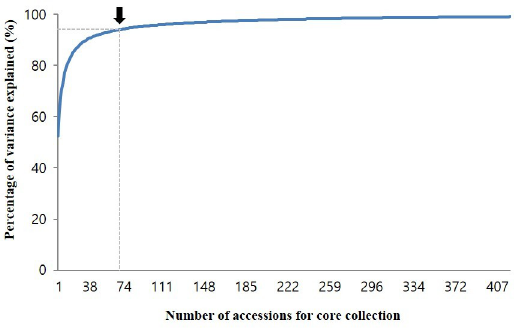
Fig 2. Principal component analysis model statistics for the core collection. The core collection was made of 407 accessions, reflecting more than 99% of the genetic diversity of the total collection. Specifically, 72 accessions reflected more than 95% of the genetic variations of the total collection (black